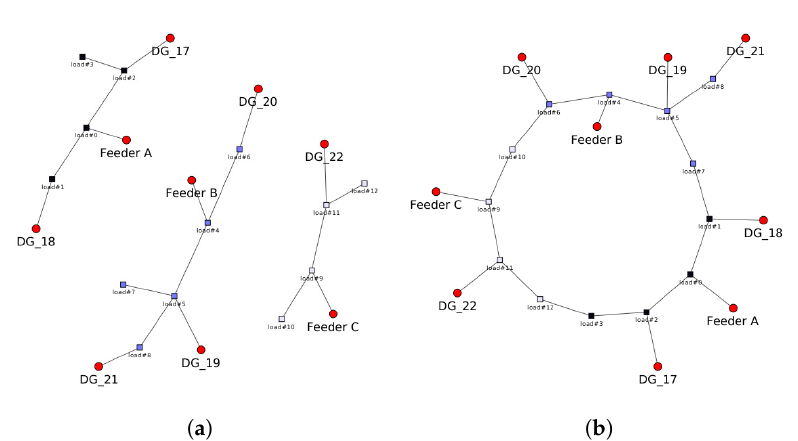
Figure 4. IEEE16 grid from [13]. Rectangular nodes are loads, red circles are generators. Colors of the loads encode the cables they belong to. ( a ) Radial version. ( b ) Meshed version.